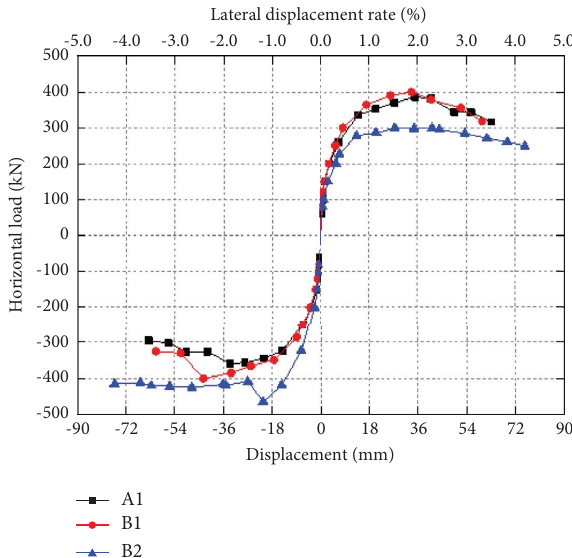
Figure 8: Skeleton curve of each